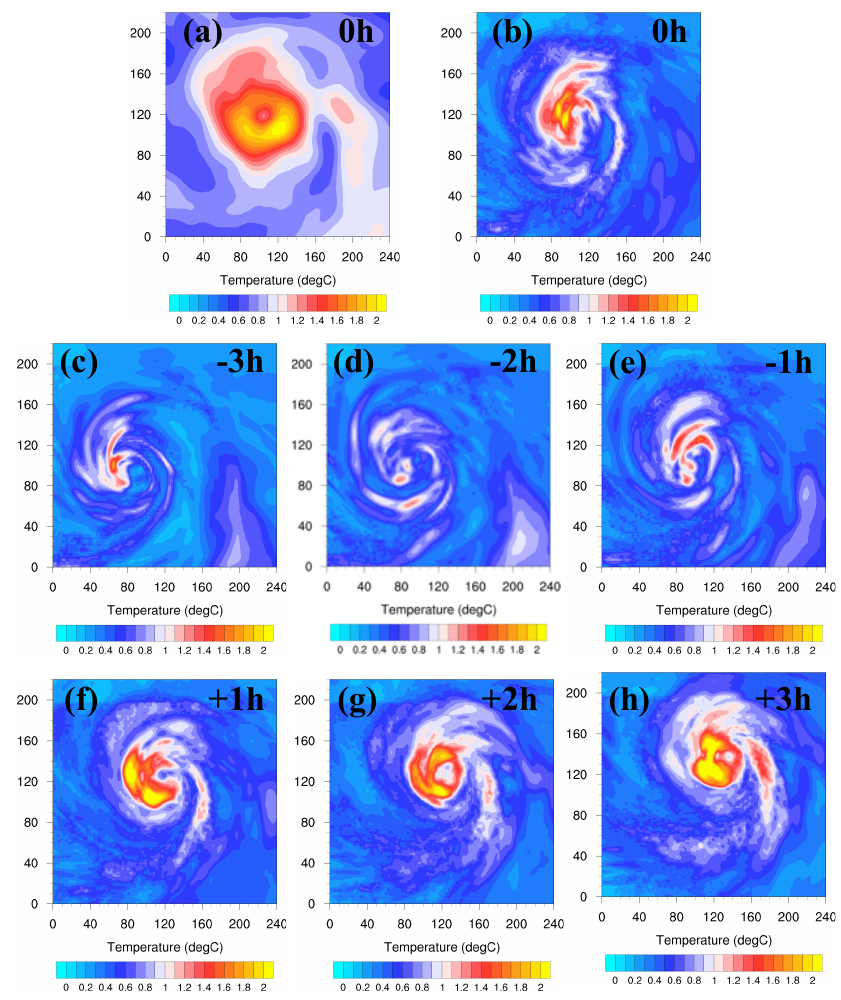
Figure 6. Ensemble spreads of temperature (unit: ◦ C) at 850 hPa within 6-h analysis window ( − 3h–3h) around 1800 UTC 03 October 2015 from ( a ) National Centers for Environmental Prediction (NCEP) Global Forecast System (GFS) ensemble Kalman filtering (EnKF) 80-member ensemble forecasts at ∼ 23 km horizontal resolution and ( b – h ) HWRF 42-member ensemble forecasts at 6 km horizontal resolution. The numbers in each plot indicate the differences between the ensemble forecast time and the analysis